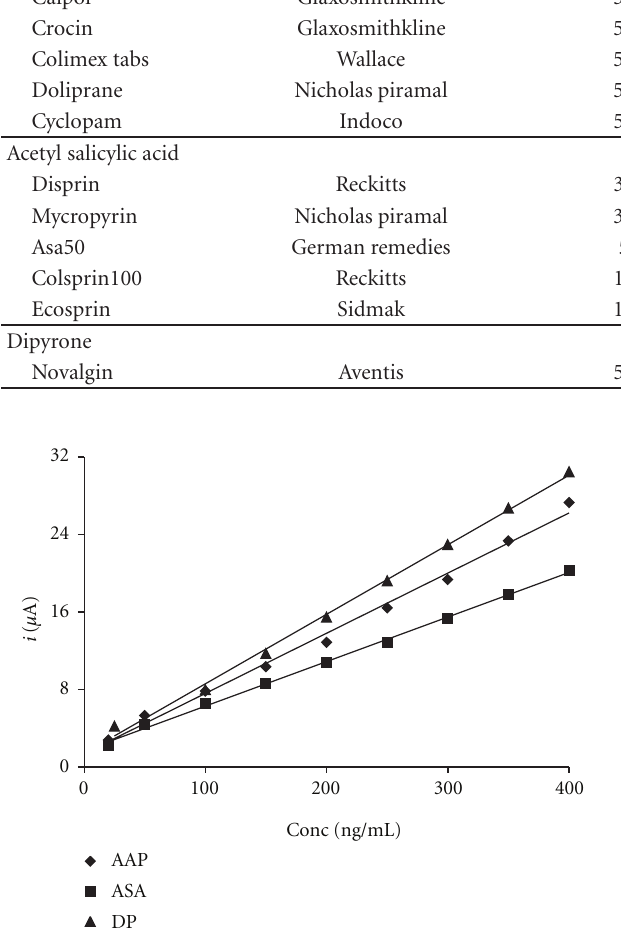
Figure 9: Calibration plot of peak current versus